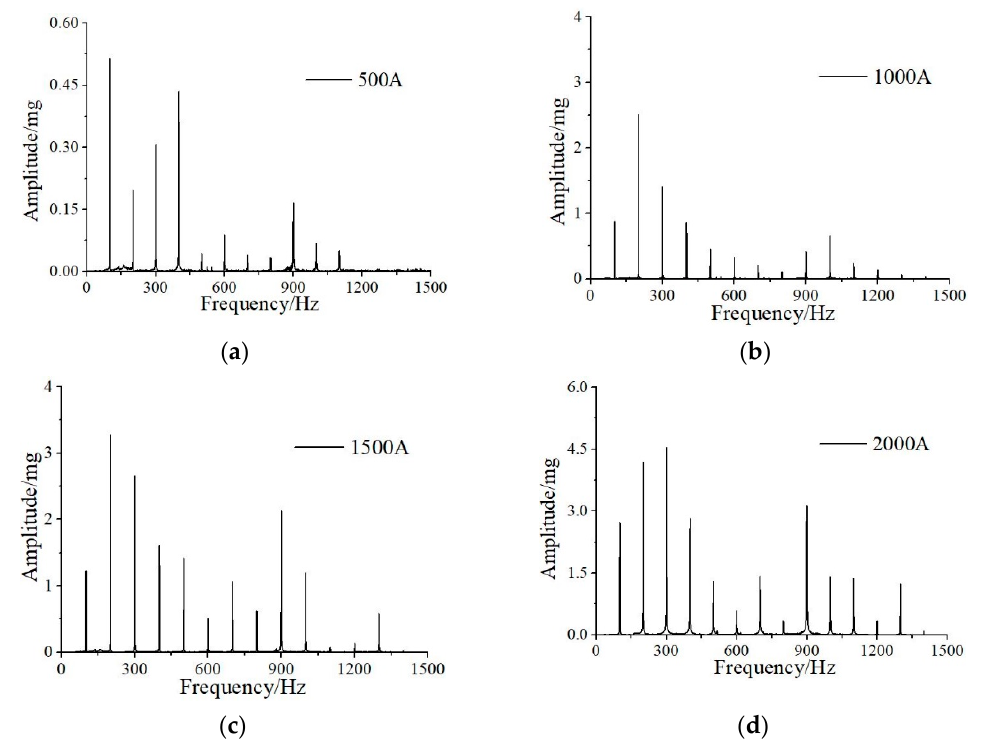
Figure 13. Frequency domain waveforms under the mild poor contact case: ( a ) 500 A; ( b ) 1000 A; ( c ) 1500 A; ( d ) 2000 A.